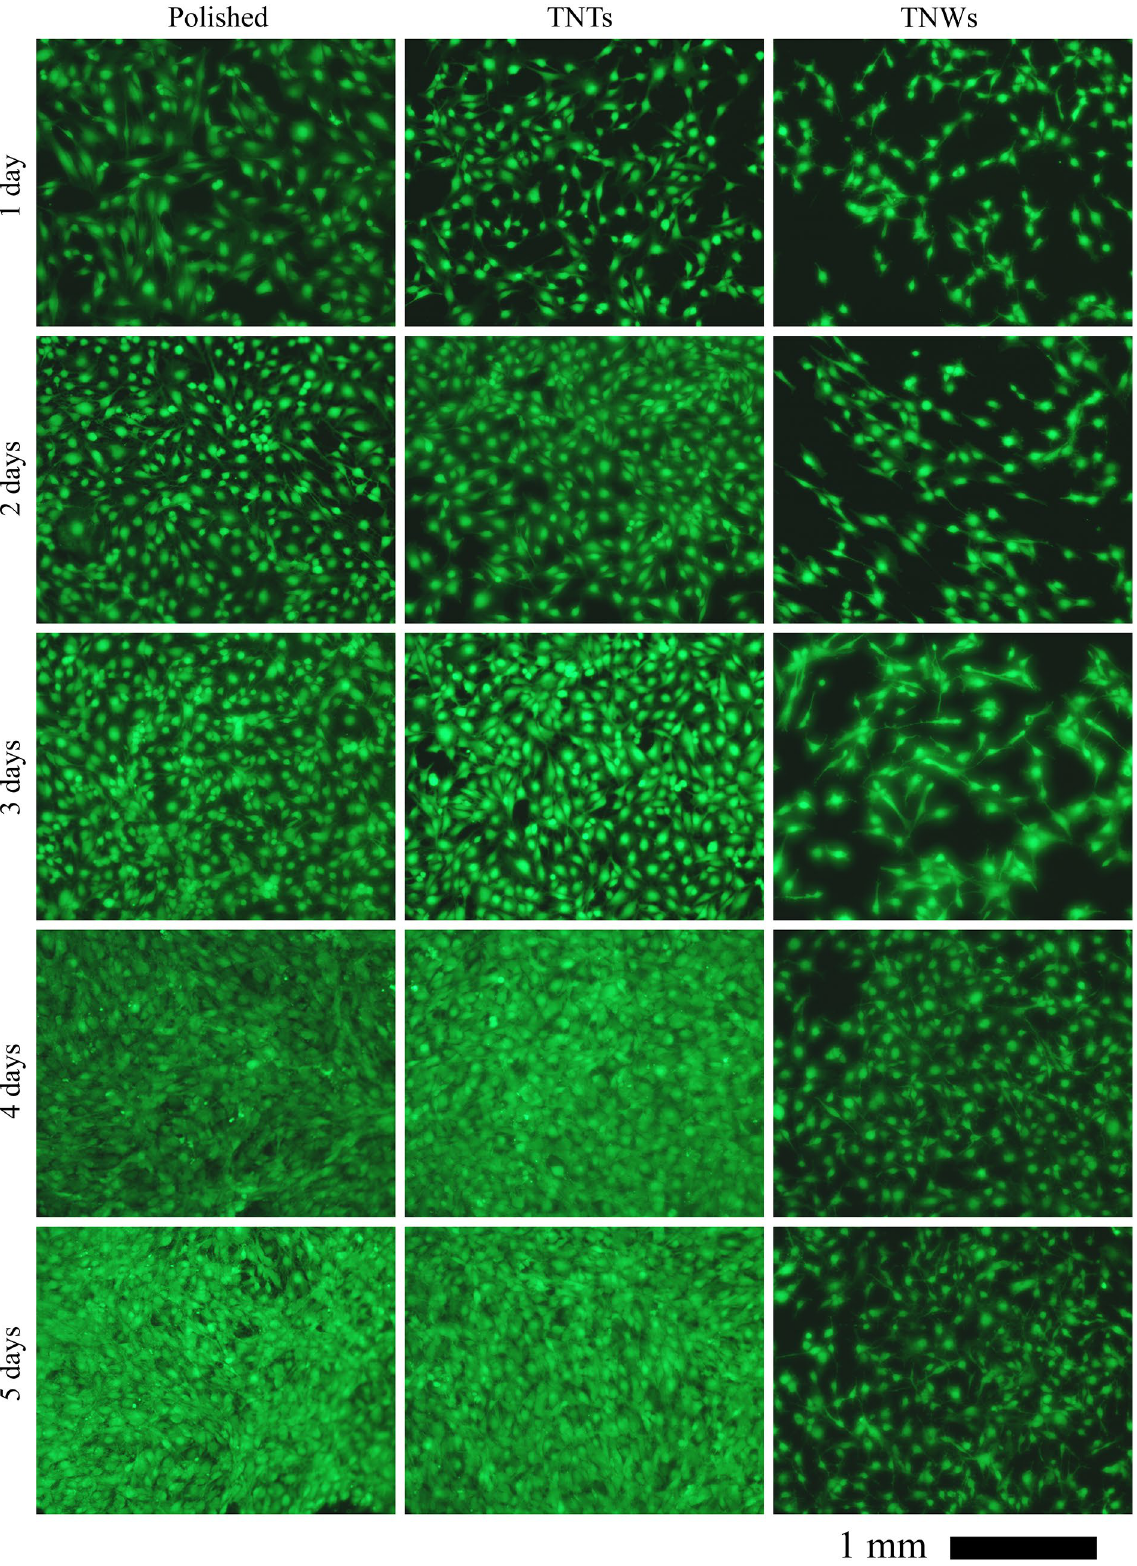
Figure 5. Fluorescence microscopy images of calcein-stained MC3T3-E1 cells on days 1 to 5 of culture on the surfaces of the chemically polished material, TNTs, and